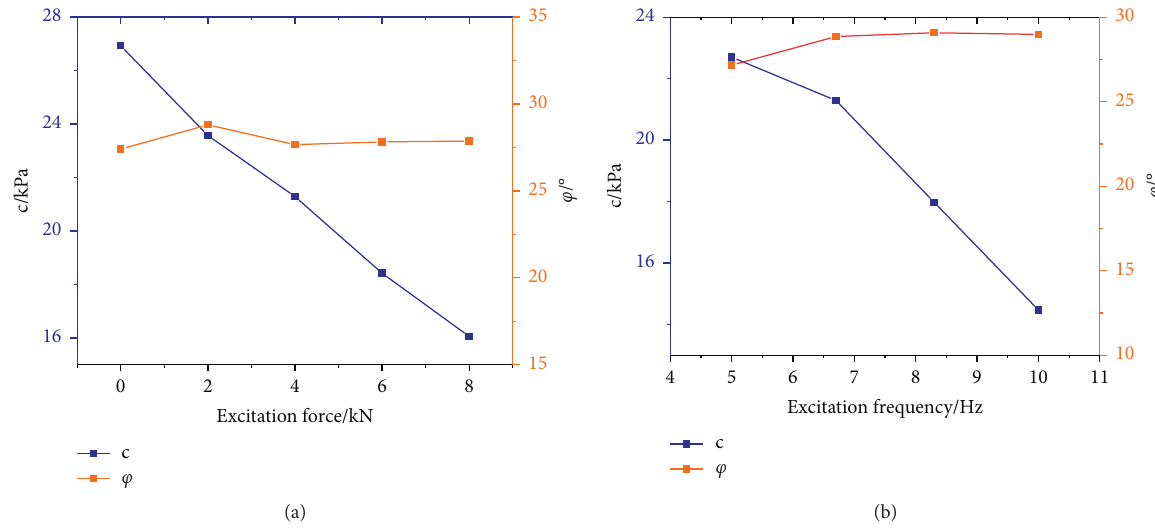
Figure 10: Soil strength parameters under different excitation conditions. (a) Excitation force. (b) Excitation frequency.